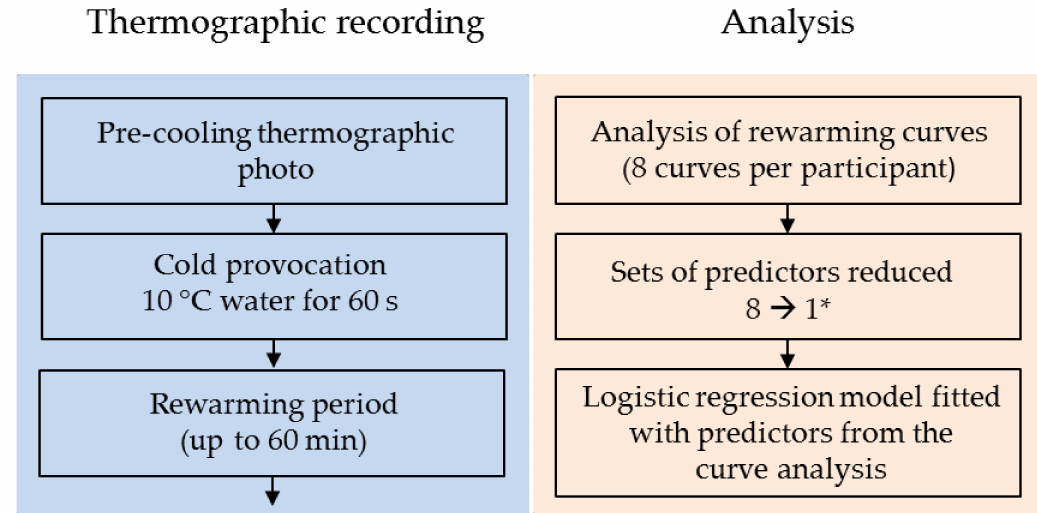
Figure 3. Flowchart of the proposed acquisition of rewarming curves after cold provocation (blue section) and the subsequent analysis of the curves, including the fitting of the prediction model (orange section). *The analysis conveyed eight sets of predictors, one set for each of the four ulnar fingers on each hand, which were reduced to one set by selection of the following values: t base (mean), t 0 (mean), t end (lowest value), time to t end (highest value). t 50 * and R% were calculated from the selected values of t base , t 0 , and t end . Curve type was classified as S-shaped if all curves were S-shaped. If one or more curves were horizontal, curve type was classified as such. t base = baseline finger temperature; t 0 = finger temperature immediately after cooling; t end = end temperature; t 50 * = finger temperature halfway through rewarming; R% = the percentage temperature recovery at end